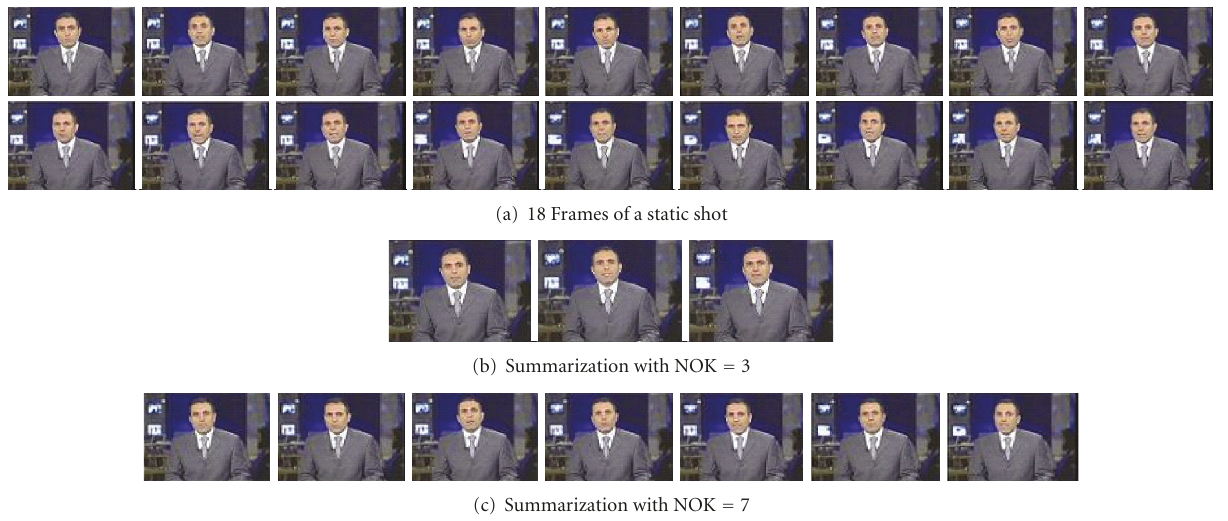
Figure 3: Some of the frames of a static shot which has been summarized with 3 and 7